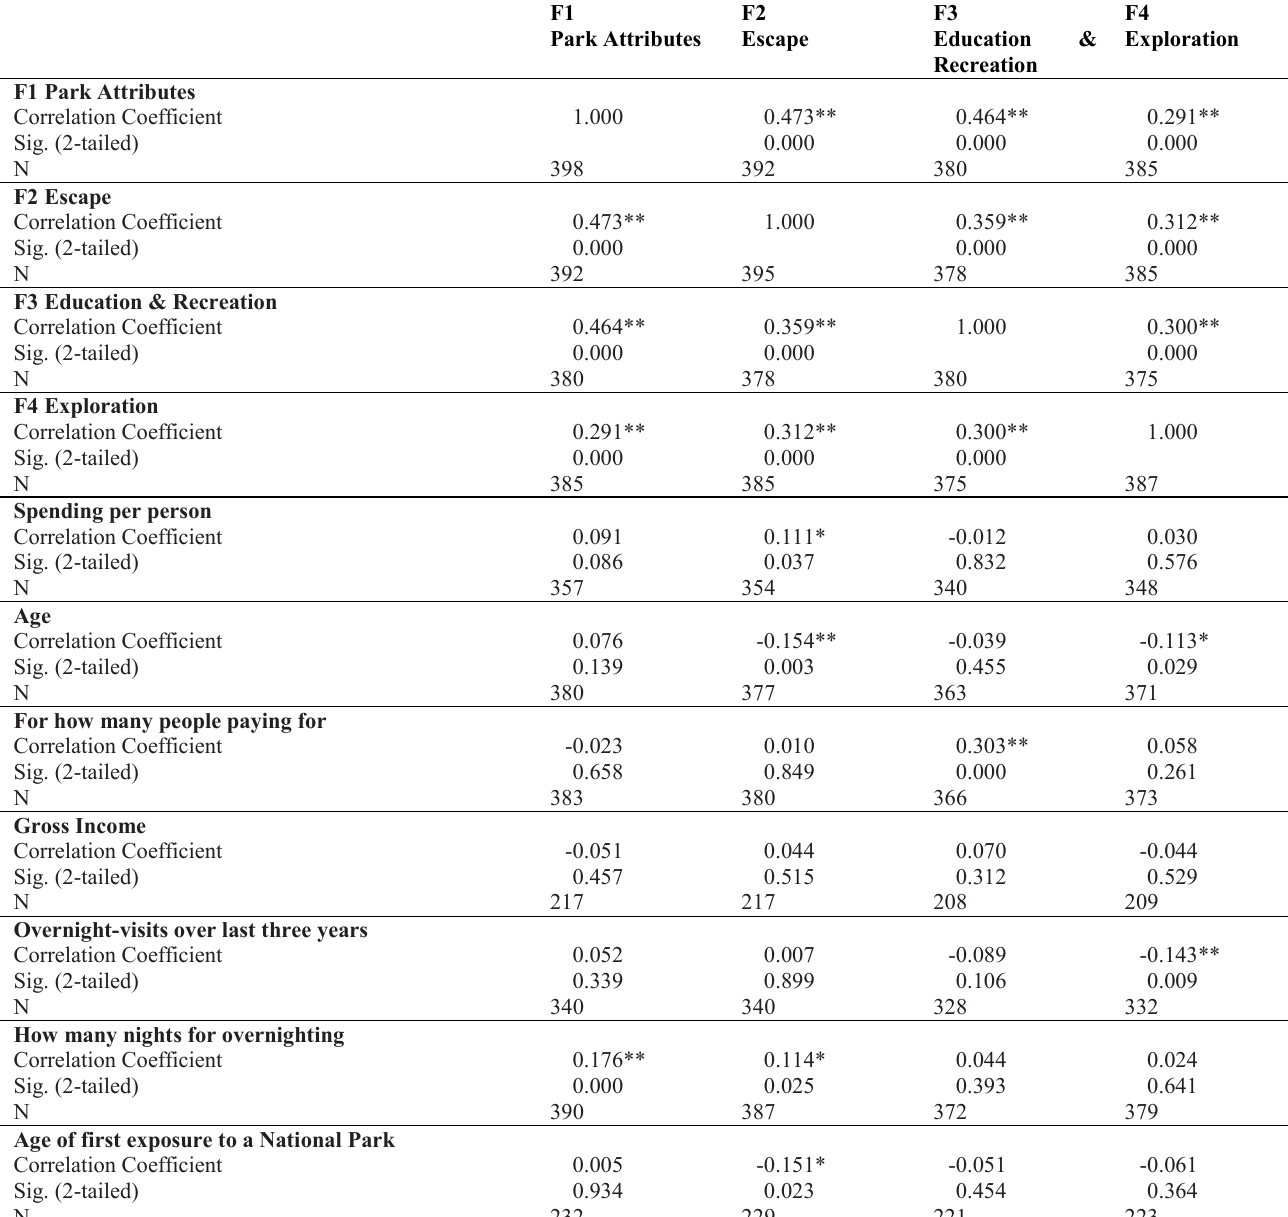
Table 6. Results of Spearman’s rho for visitor characteristics ( n =